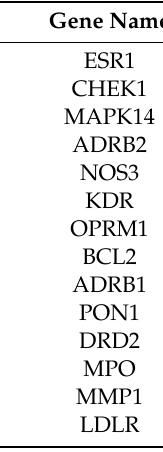
Table 5. Direct Action of 14 LC Therapeutic targets.